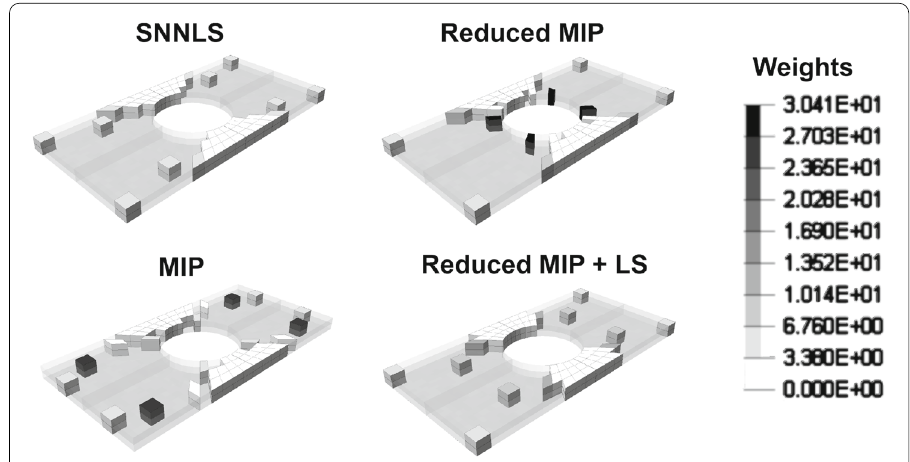
Fig. 15 Element selection for the hyper-reduced integration schemes of size fourteen computed with the different methods